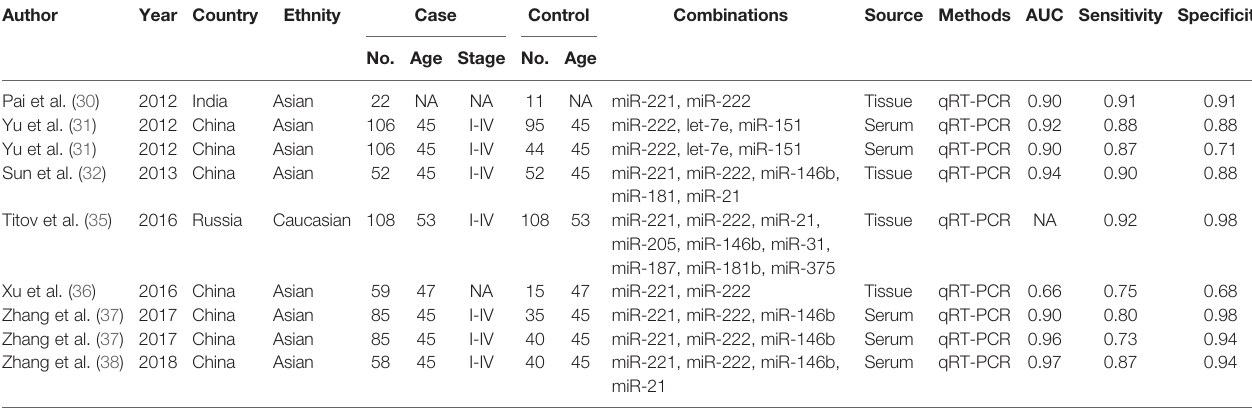
TABLE 3 | The main features of the included studies on combination markers containing miR-221/222 in the diagnosis of